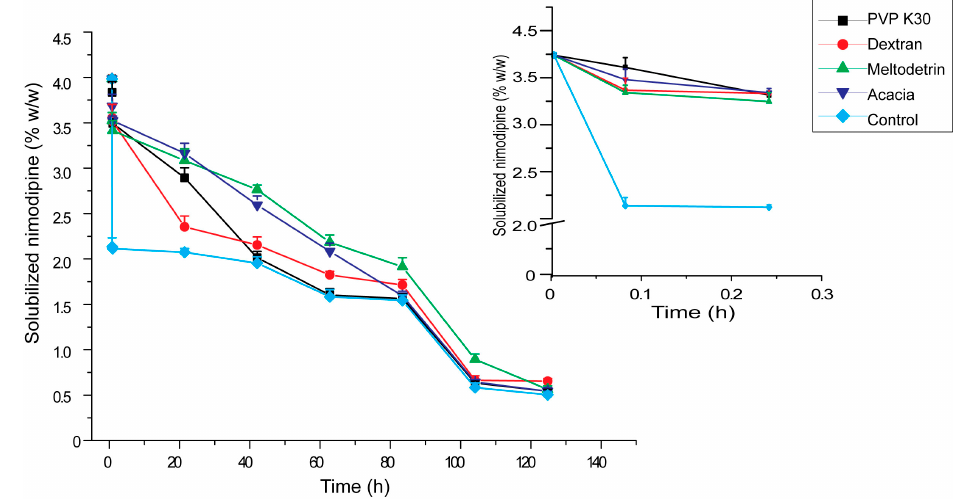
Figure 4. Effects of hydrophilic carriers on the in vitro dispersion of SMEDDS in simulated gastric fluid. The control group was the SMEDDS without any carriers ( n = 3). Pharmaceutics 2019 , 11 , x